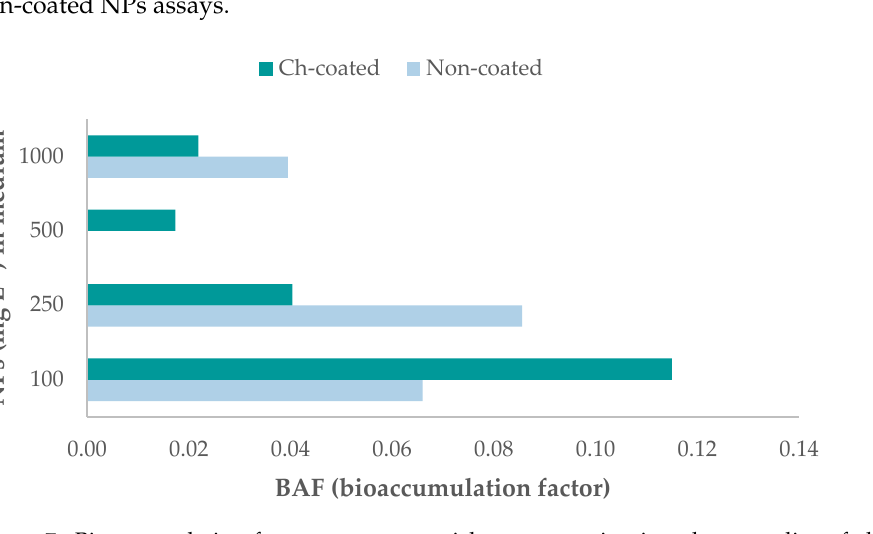
Figure 7. Bioaccumulation factor per nanoparticle concentration in culture medium fed to flies. Results shown for non-coated and chitosan-coated magnetite nanoparticles.